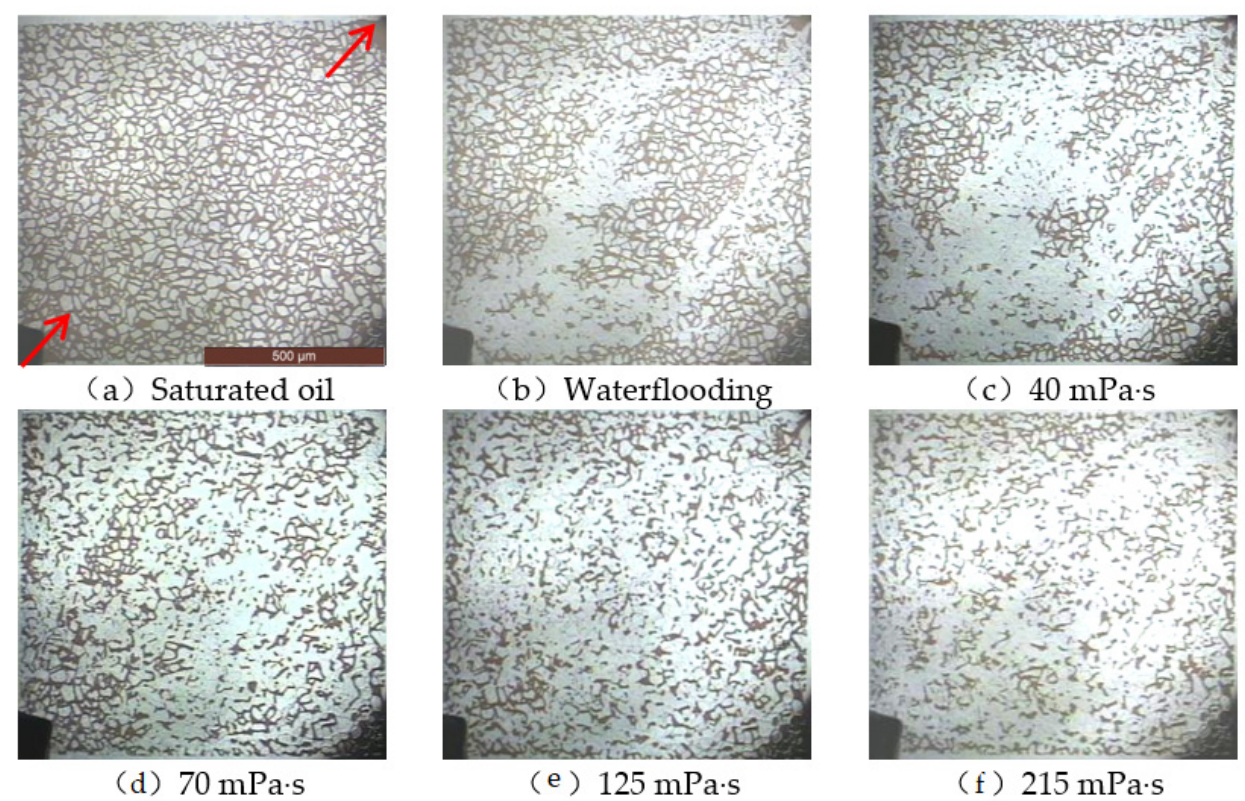
Figure 10. Oil displacement effect of polymers with different viscosities. ( a ) Saturated oil. ( b ) Water-